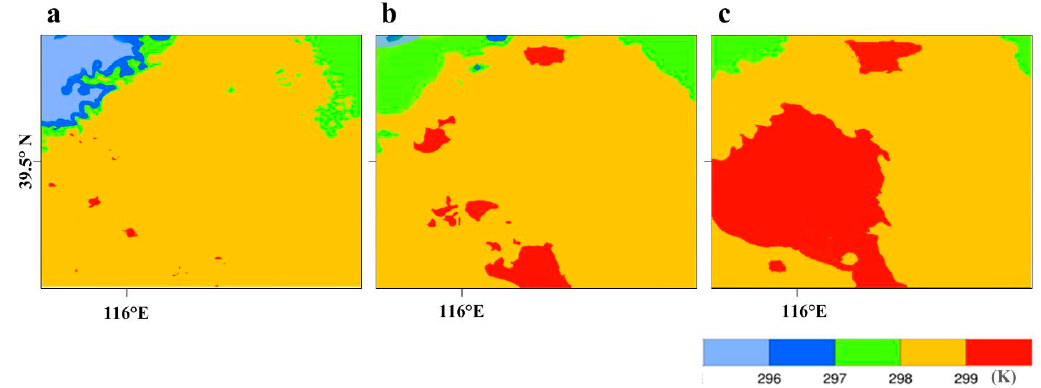
Figure 3. Average night temperature (K) at 2 m for different land cover. ( a ) NU, ( b ) CU, ( c ) FU.